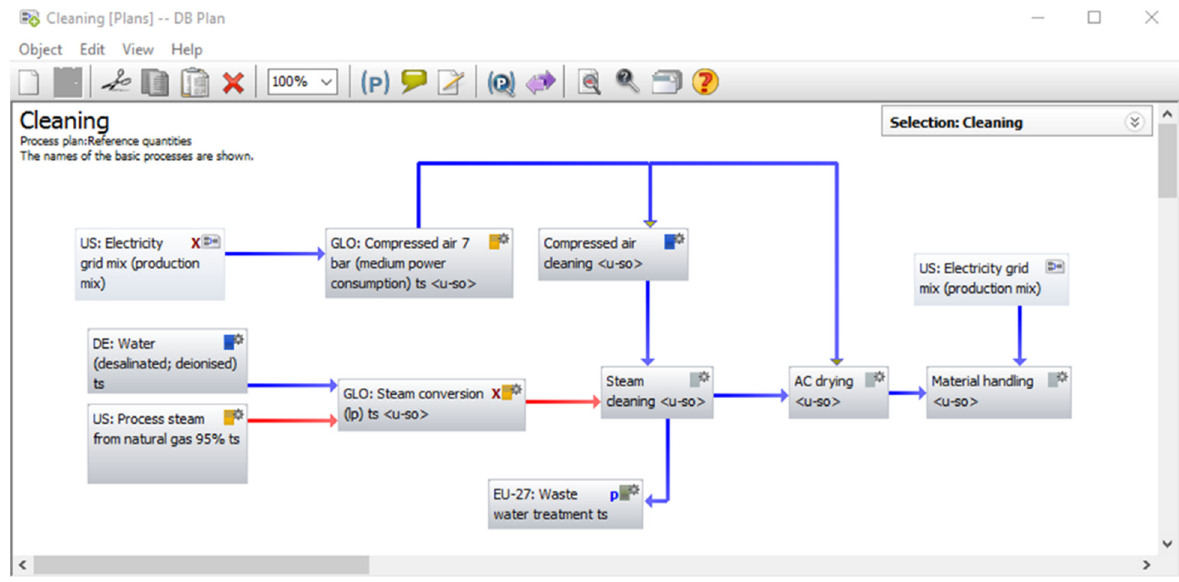
Figure 5. The cleaning phase modeling using GaBi software.